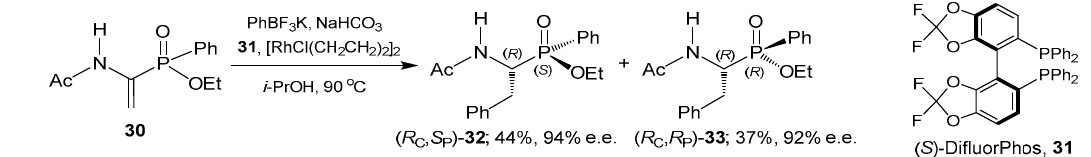
Scheme 19. Optimized conditions for the catalytic hydrogenation of 27a – g .